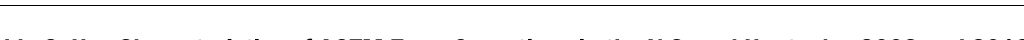
Table 2. Key Characteristics of AOTM Farm Operations in the U.S. and Kentucky, 2002 and